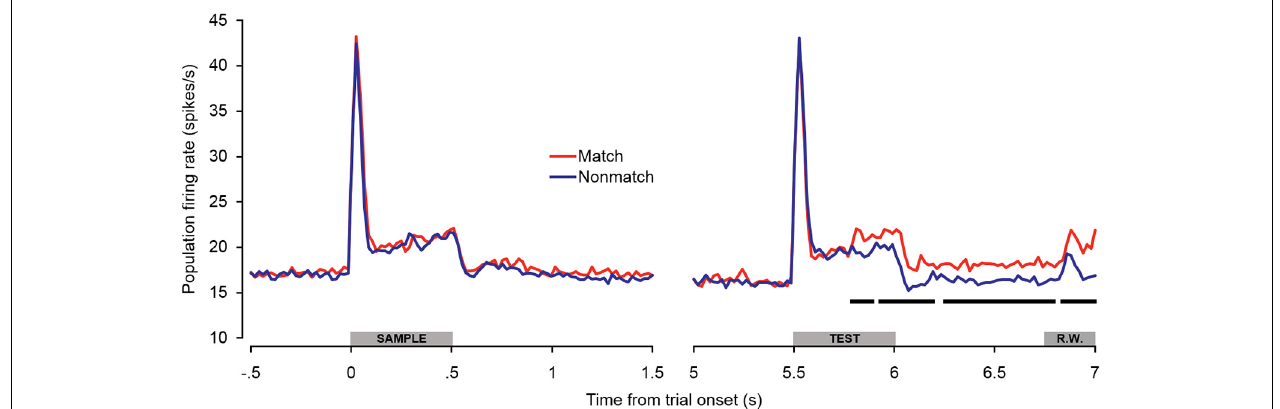
FIGURE 5 | Population spiking activity during auditory short-term memory task. Firing rates elicited by matching and non-matching test stimuli are depicted in the right panel, and firing rates elicited by the sample stimuli are shown in the left panel as a control comparison. Beginning during the latter portion of the test stimulus presentation period, firing rates became significantly higher for match compared to non-match trials. This difference was sustained with minimal interruption throughout the offset and